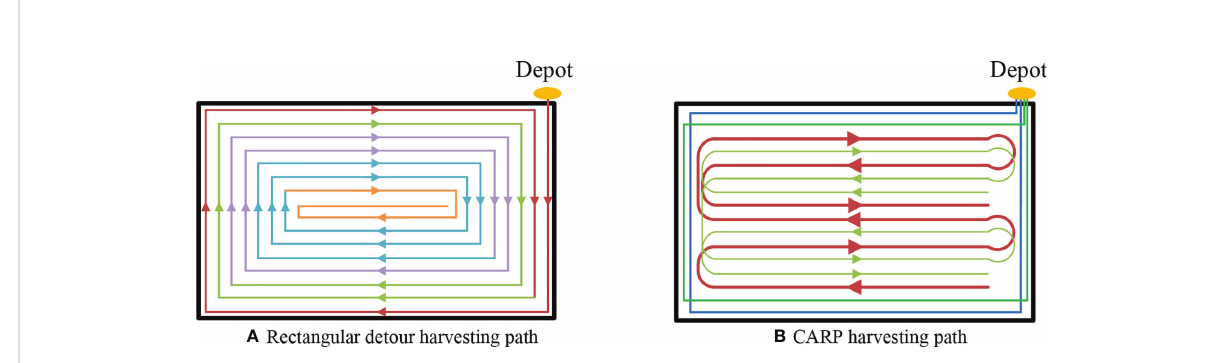
FIGURE 9 Path results under different path planning methods within a regular fi eld block (A) . Rectangular detour (B) . CARP harvesting path harvesting path.